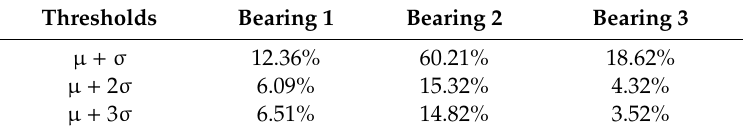
Table 1. The standard error of remaining useful life (RUL) prediction under three thresholds.